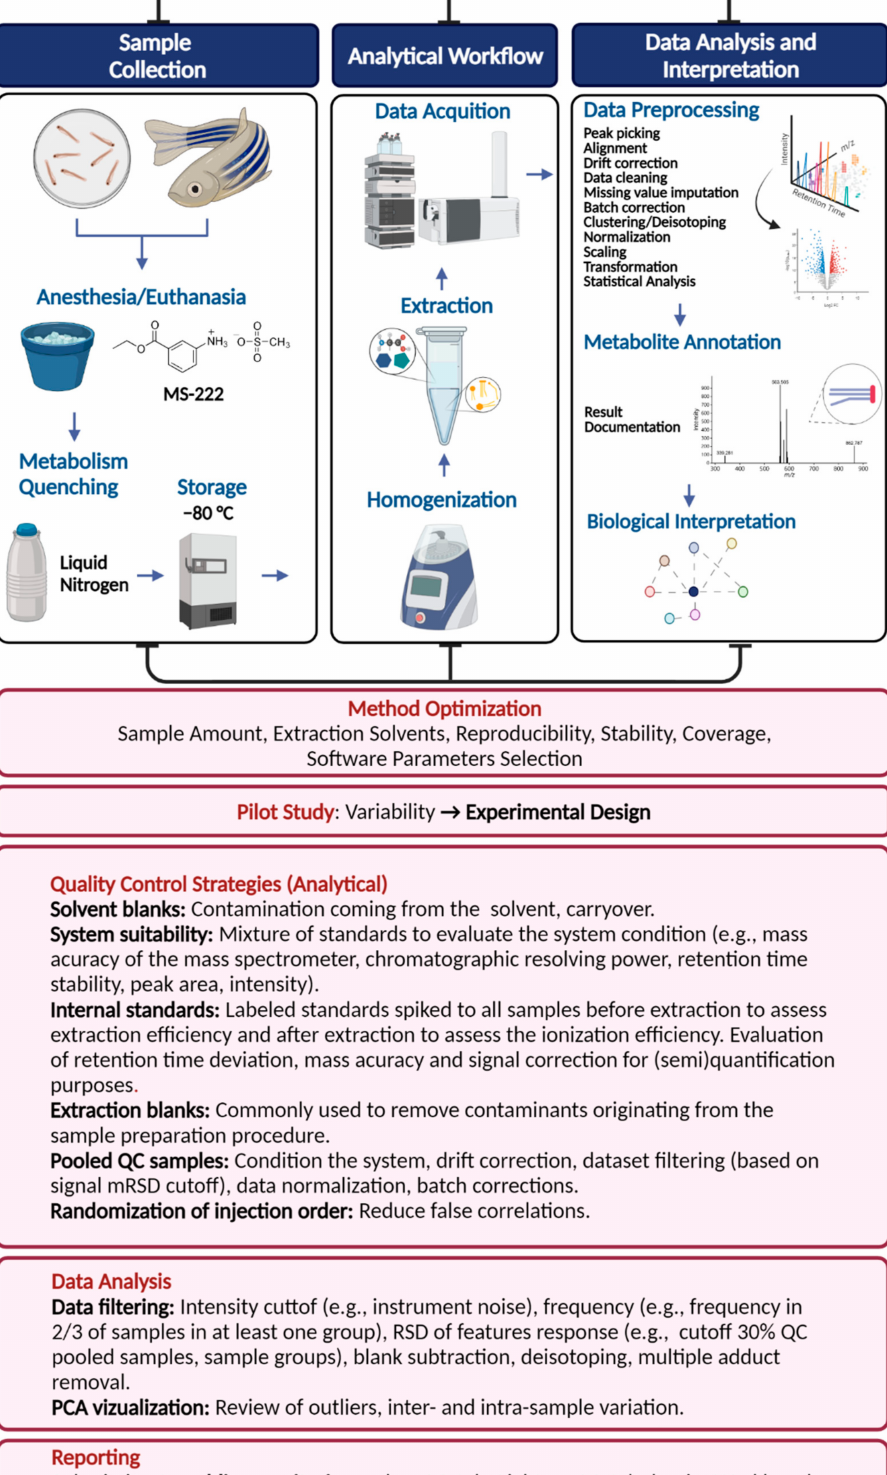
Figure 1. Quality management system strategies in the zebrafish metabolomics